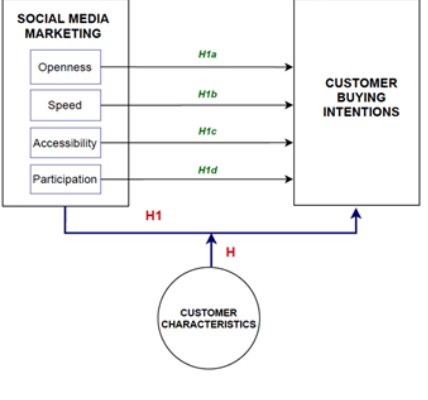
Fig. 1. Proposed Research